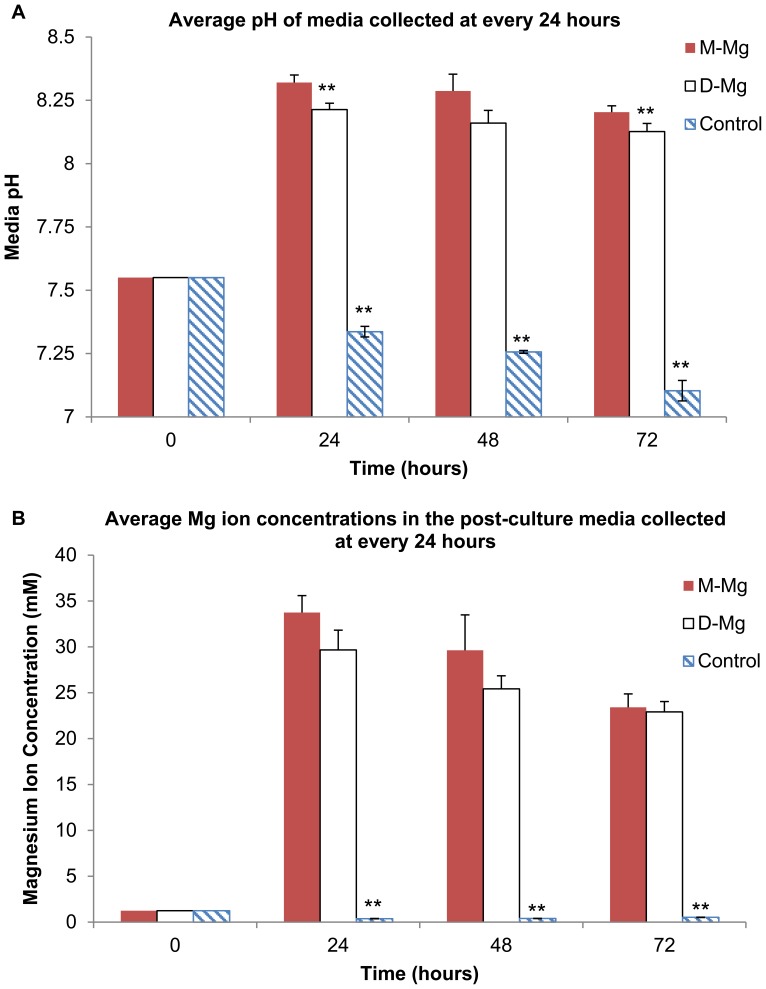
Media pH and Mg ion concentrations in the media collected at every 24 hours after hESCs were cultured with M-Mg and D-Mg for 72 hours.(A) The average pH and (B) the average magnesium ion concentrations (**p<0.05 compared to M-Mg). Values are mean ± standard deviation: n = 3. The average pH and Mg ion concentrations for the culture with both Mg samples significantly increased as compared with the control without Mg samples. The statistically significant lower pH of the post-culture media with D-Mg was detected in comparison with M-Mg. Furthermore, after 24 hours, a general trend of gradual decrease in average pH and magnesium ion concentrations over time was observed for both Mg samples. (**p<0.05 compared to M-Mg). Values are mean ± standard deviation: n = 3.